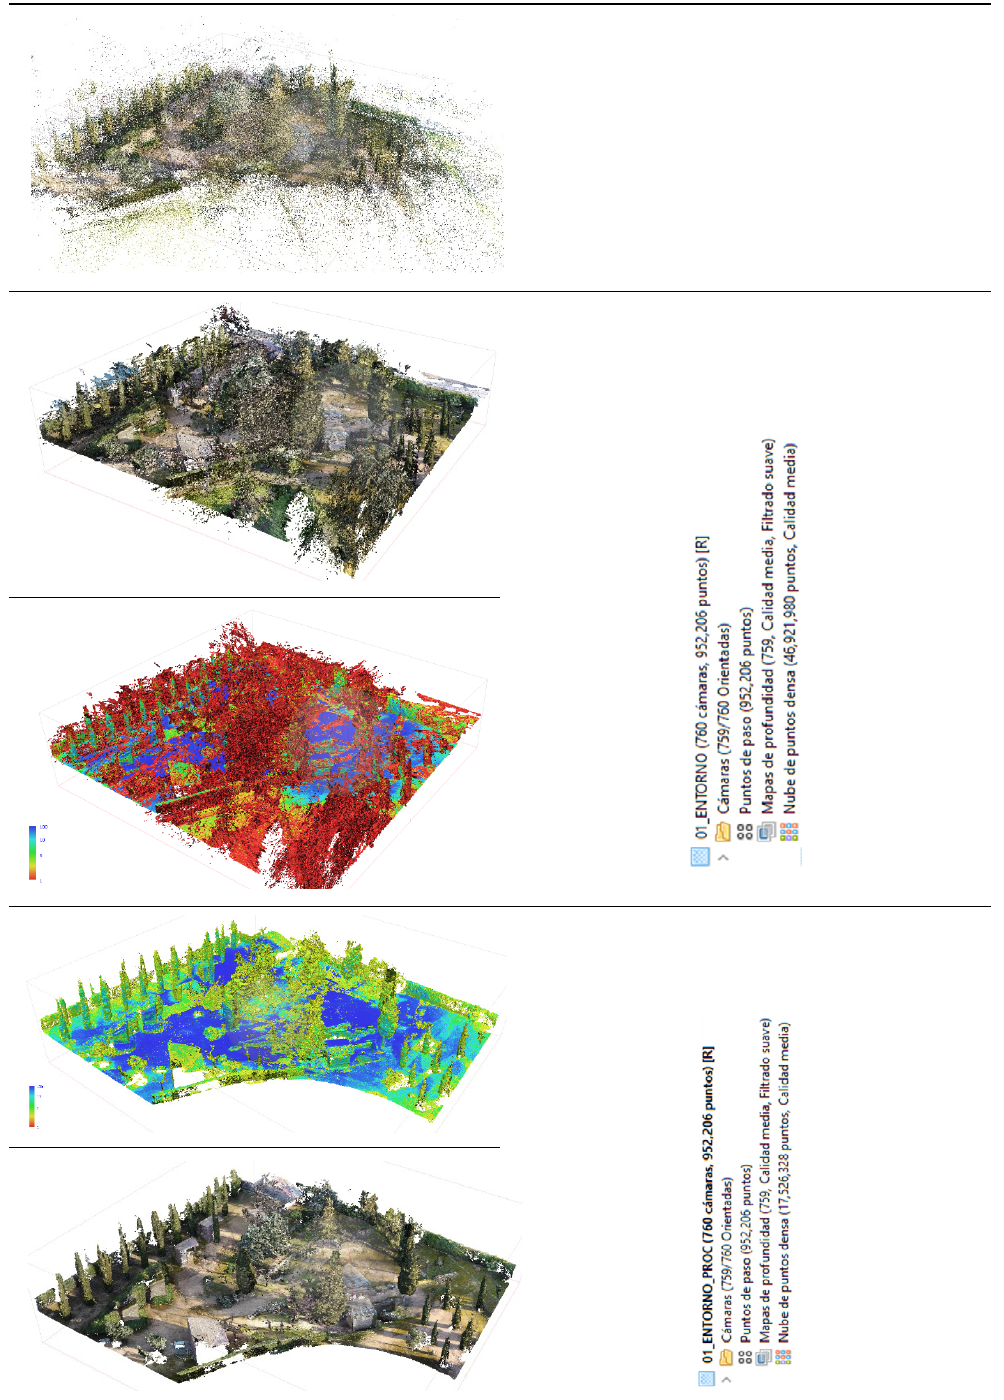
Table 6. Point cloud generation process in Photoscan of the topography of the environment.